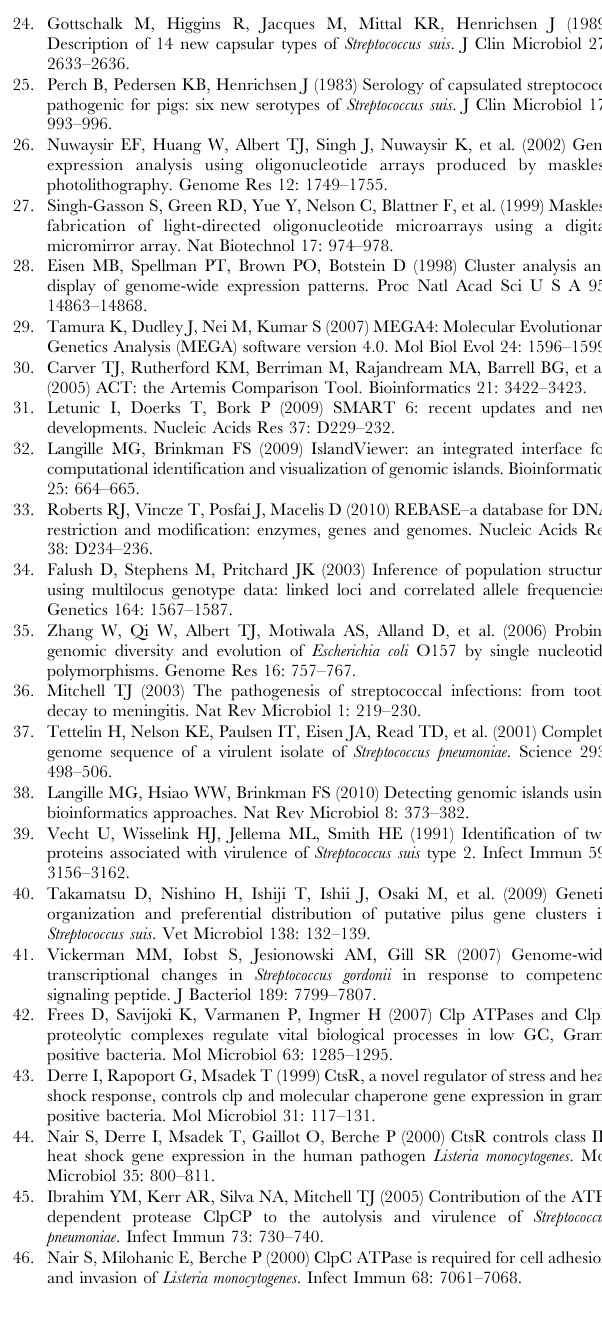
Table S5 Summary of SVG and their distribution in 31 test strains according to their pathogenic